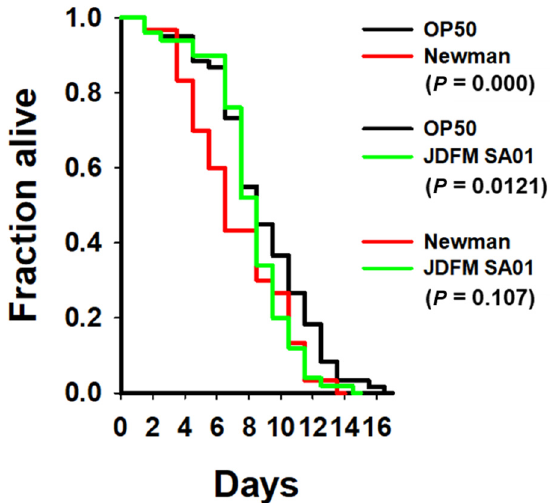
Figure 1. The survival rate of C. elegans worms infected with S. aureus JDFM SA01. Survival statistics: S. aureus JDFM SA01-conditioned nematodes compared with worms feeding on S. aureus